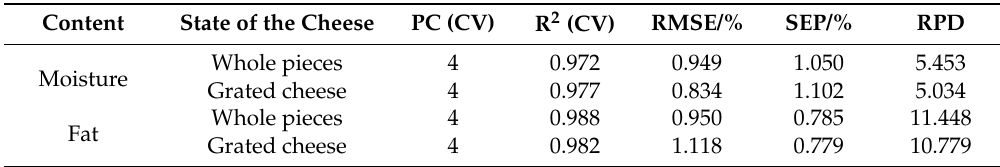
Table 4. Statistical parameters of the established PLS-R models for moisture and fat content. CV denotes cross-validated